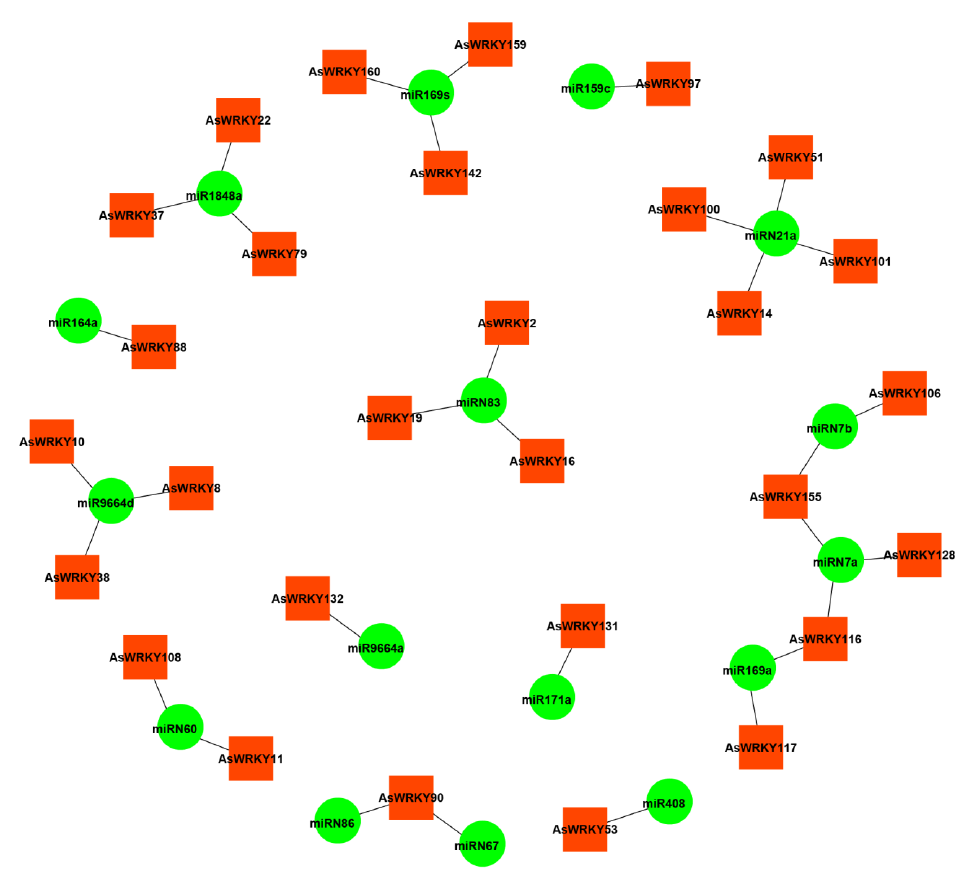
Figure 8. miRNA-AsWRKY